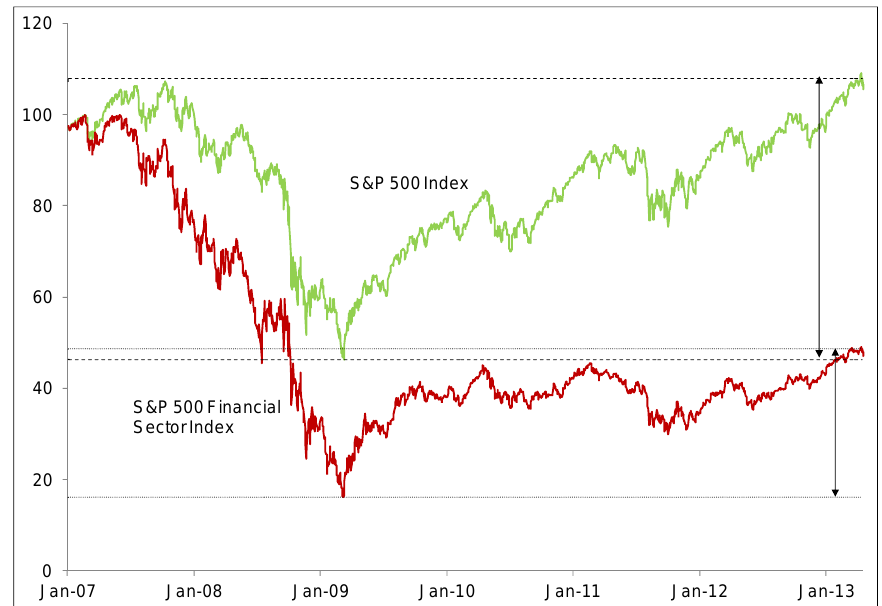
Figure 6. United States: S&P 500 Stock Market and Financial Sector Indices (Indexed to 100 on February 20,